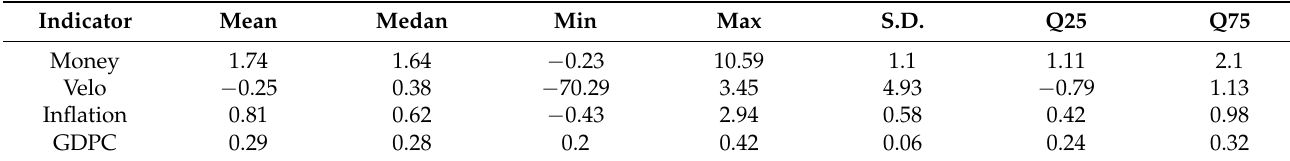
Table 3. Descriptive statistics in percent, quarterly.